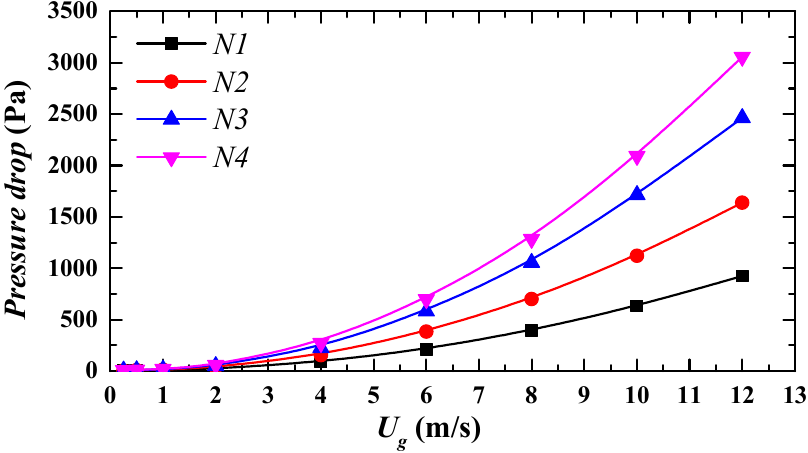
Figure 5. Pressure contour of demisters versus U g in different class numbers N .